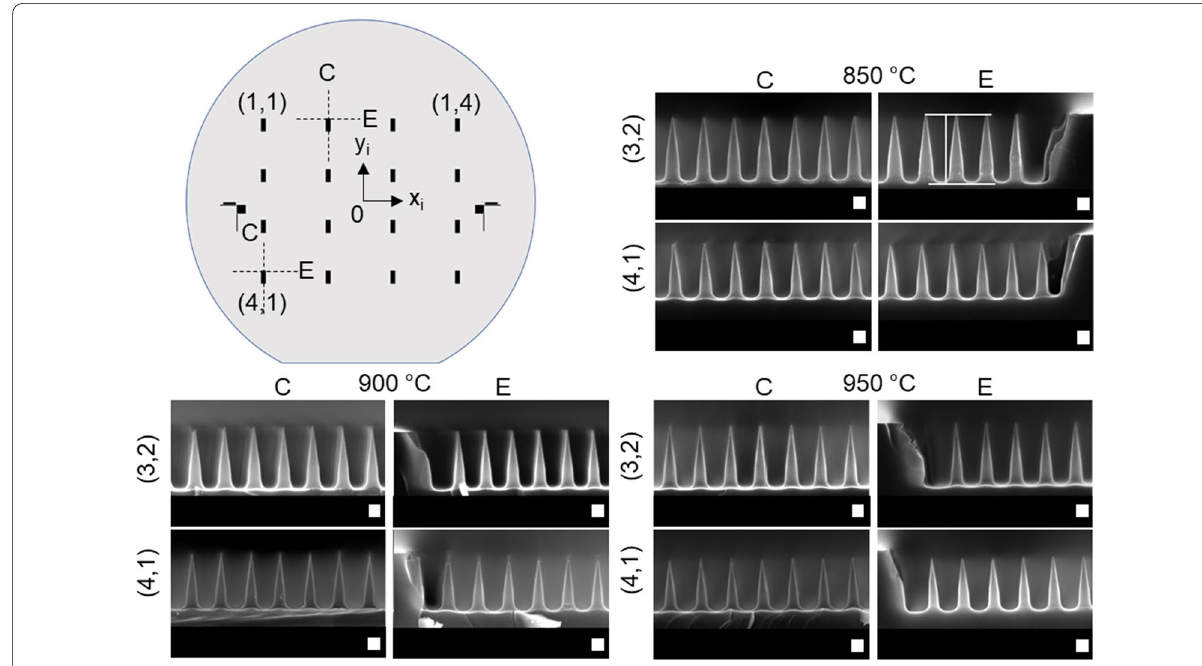
Fig. 7 A top-view schematic representation of a 100-mm-diameter silicon substrate map is shown in the top-left corner. The black rectangular boxes indicate the SiNC arrays (size 1.5 4 mm 2 ) on the substrate where the SiNC arrays are present. Two dotted lines show examples of the × locations where the cleaving planes are supposed to intersect the nanocone arrays. Cross-sectional SEM images displayed in this figure were recorded at the cleaving planes, showing SiNC arrays fabricated at oxidation temperatures of 850, 900, and 950 °C and recorded at different locations. Height measurements of the coated and stripped SiNC arrays are conducted, as shown in (850 °C; C; (3,2)). The scale bars represent 100